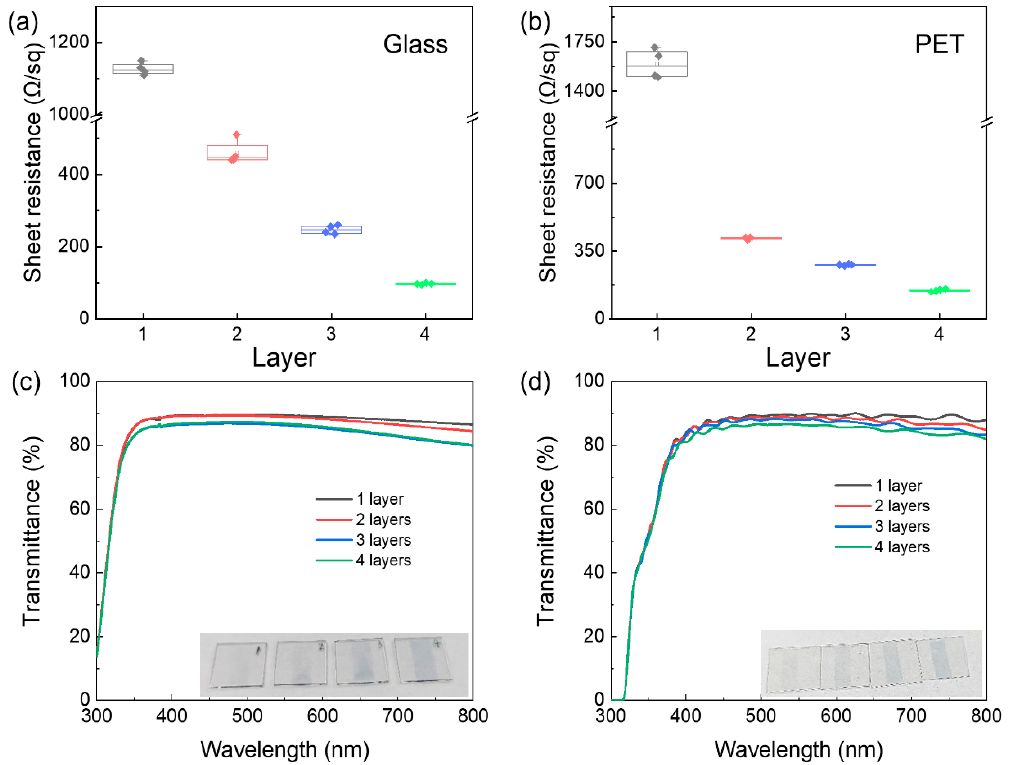
Figure 3. The sheet resistance dependent on the layer number of the PEDOT:PSS electrode on ( a ) glass and ( b ) PET substrates, respectively. The effect of layer number on the transmittance of the PEDOT:PSS electrode on ( c ) glass and ( d ) PET substrates, respectively. (Inset: images of PEDOT:PSS films with various layers on glass and PET substrates).